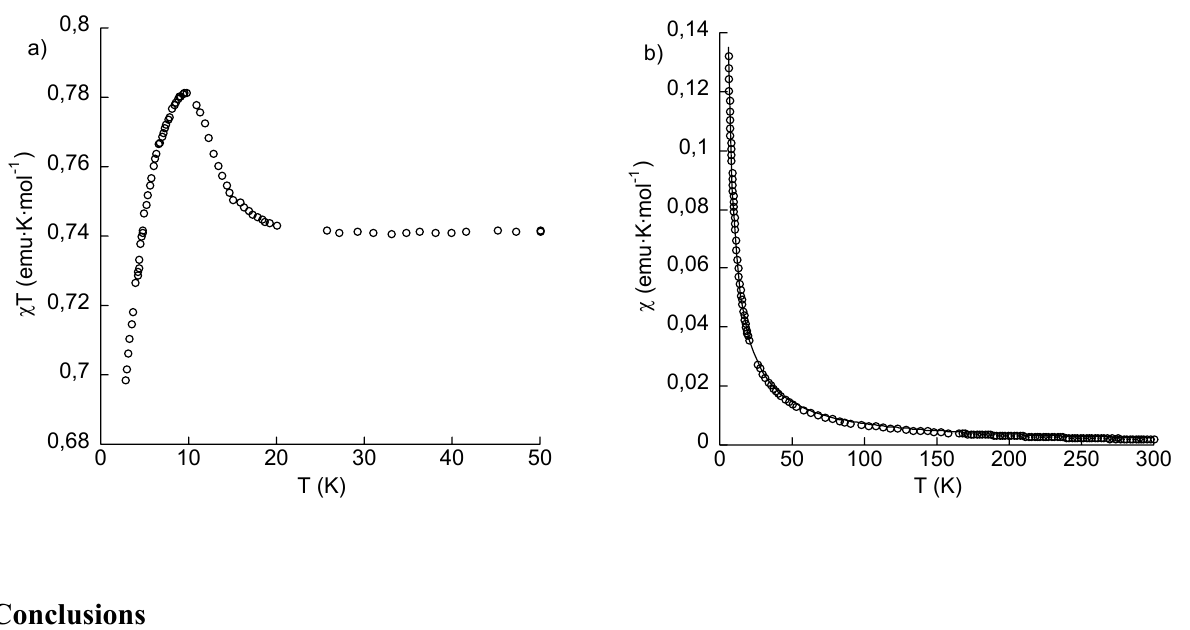
Figure 6. Temperature dependences of χ T (a) and χ (b) for 2 . The solid line corresponds to the best-fit to data with the Bleaney-Bowers equation ( J = + 0.25